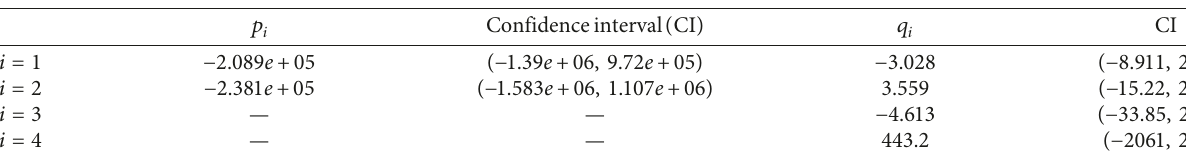
vs. HoF. 3 vs. HoF. 1